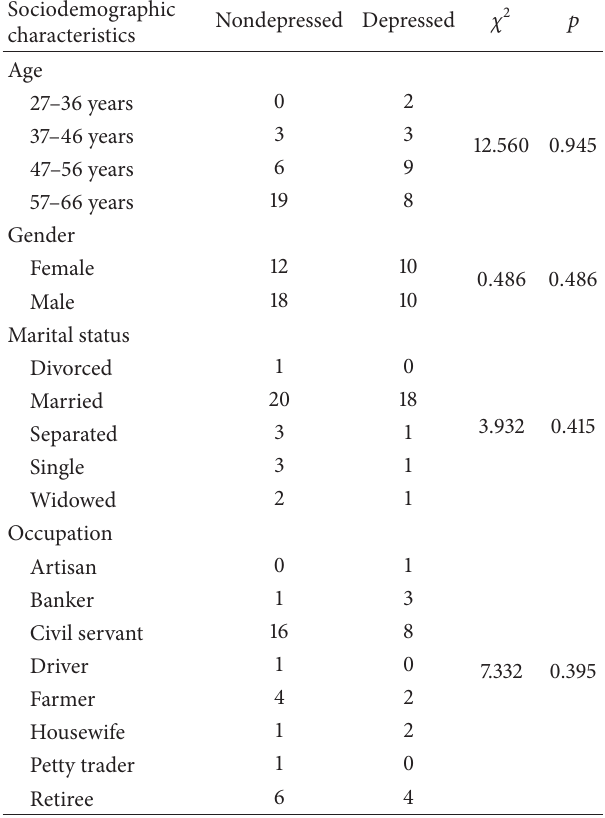
Table 2: Relationship between depression and sociodemographic variables (age, gender, marital status, and occupation; 𝑁 = 50